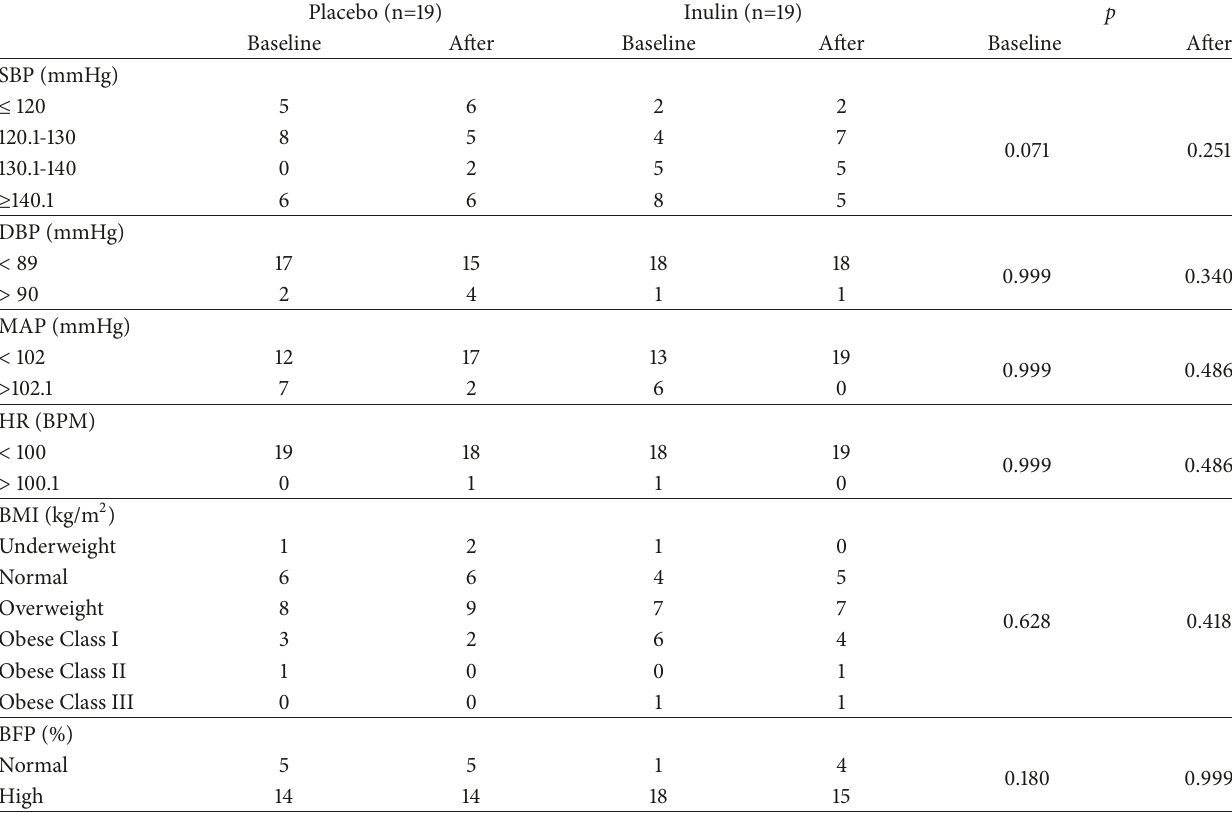
Table 3: Frequency of women according to classification of blood pressure, HR, BMI, and BFP vs. supplementation group. Placebo (n=19) Inulin (n=19) p Baseline After Baseline After Baseline